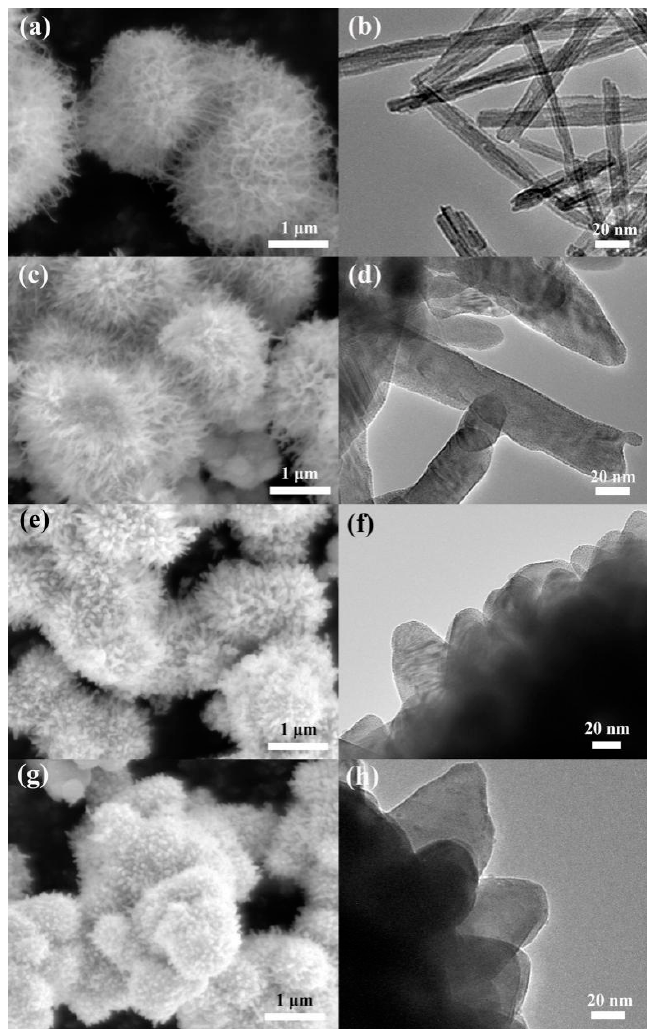
Figure 4. SEM ( a, c, e, g ) and TEM ( b, d, f, h ) images of W400, W450, W500 and W550. Figure 4. SEM ( a , c , e , g ) and TEM ( b , d , f , h ) images of W400, W450, W500 and